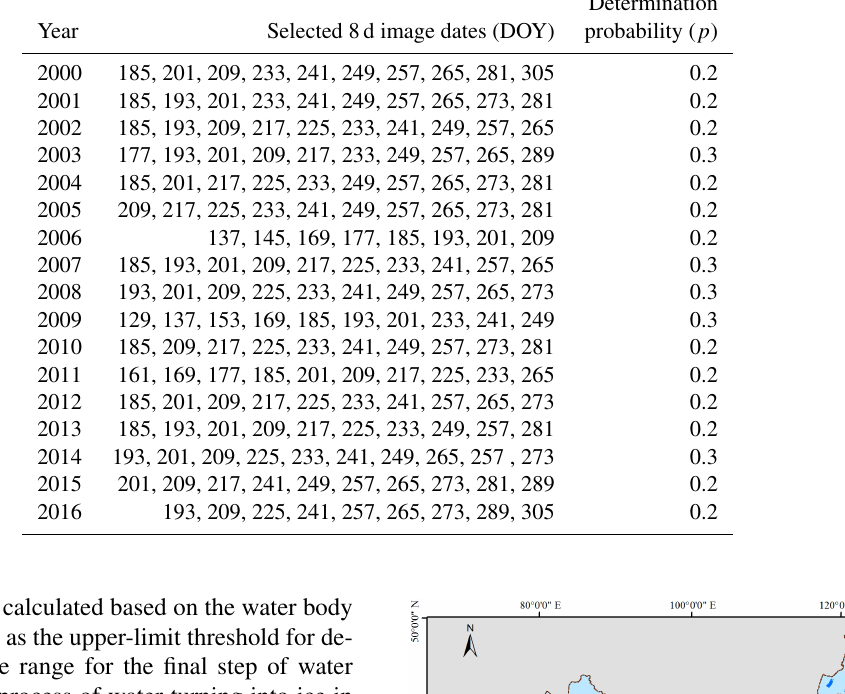
Table 2. The images used for annual water surface mask generation and the determination probability each year. Determination Year Selected 8d image dates (DOY)